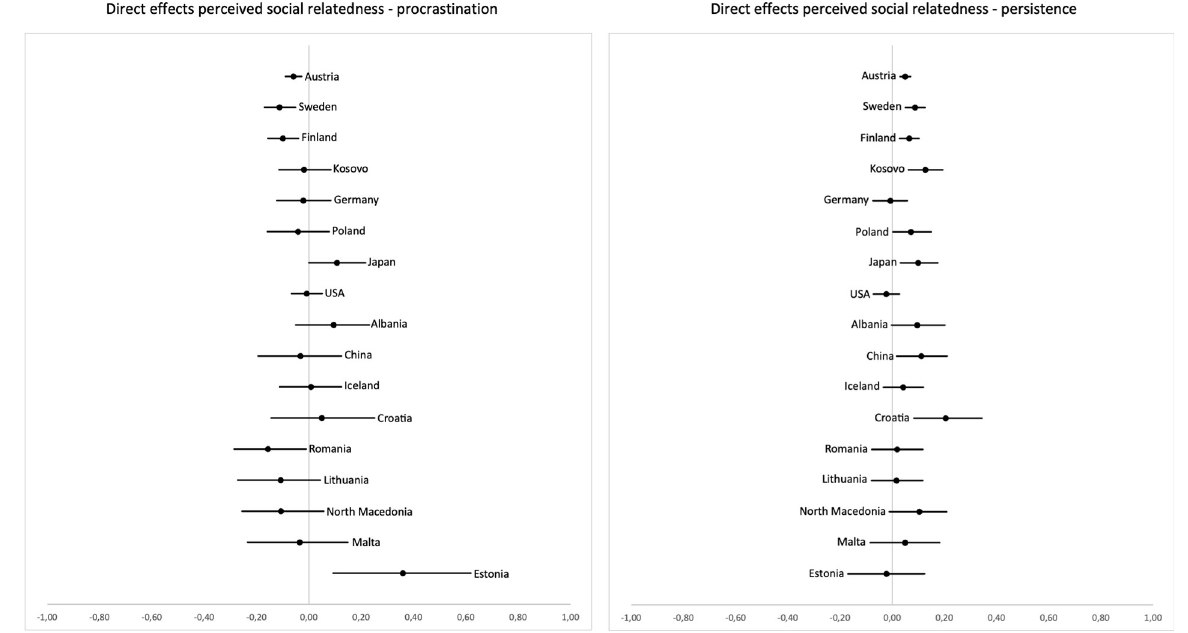
Fig 5. Unstandardized coefficients and two-sided 5% confidence intervals for the direct effects of perceived social relatedness on procrastination (left) and persistence (right). Countries are ordered by sample size from top (highest) to bottom (lowest).